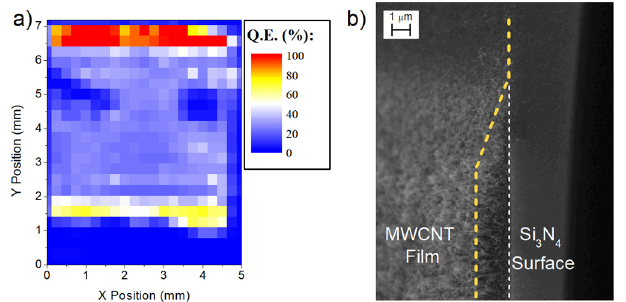
Figure 3. ( a ) Quantum efficiency map of a device (with pristine MWCNT film) that shows efficiency inhomogeneities across its surfaces. The device presents an average QE of 30%, but near the top and bottom edges, the QE increases to nearly 100%. ( b ) SEM images of the top-right corner of the MWCNT film. The film presents two types of edges: the top edge, which decreases gradually, and the right edge, which is sharper and akin to a